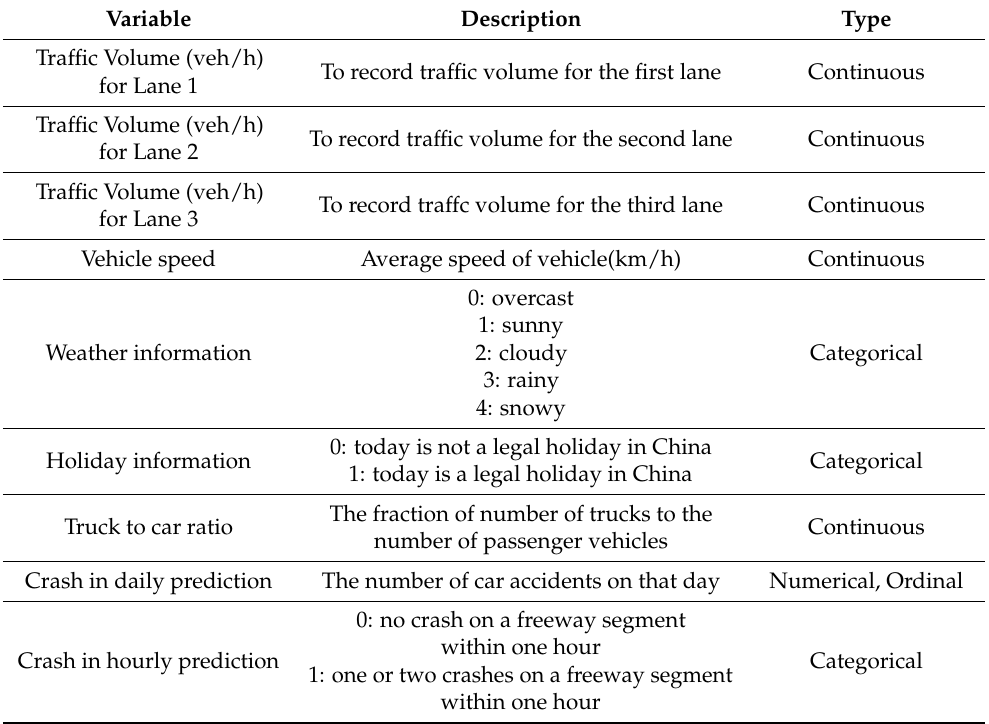
Table 1. Overview of